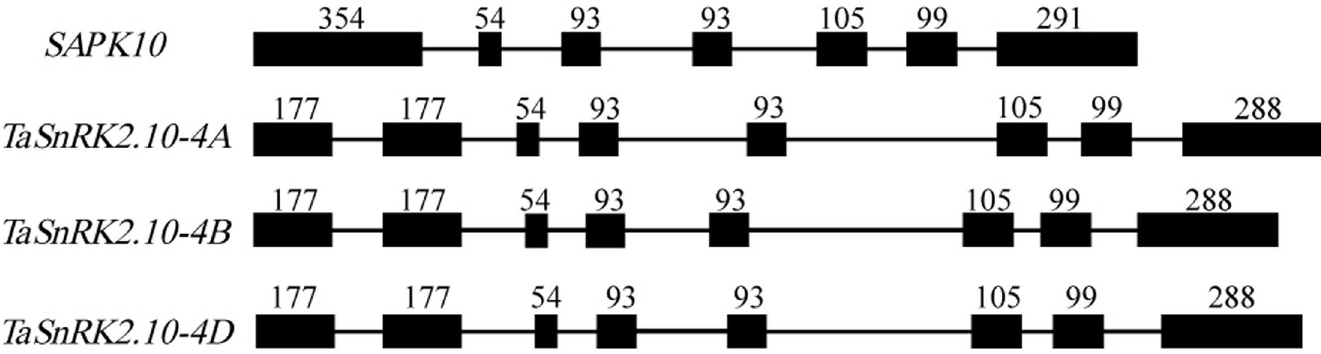
Fig 2. The structuresof the TaSnRK2 . 10 gene from 4A, 4B and 4D homoeologs in wheat. The black boxes denote exons, and the lines between exons representintrons. The numbers upon exons indicatetheir size (bp).